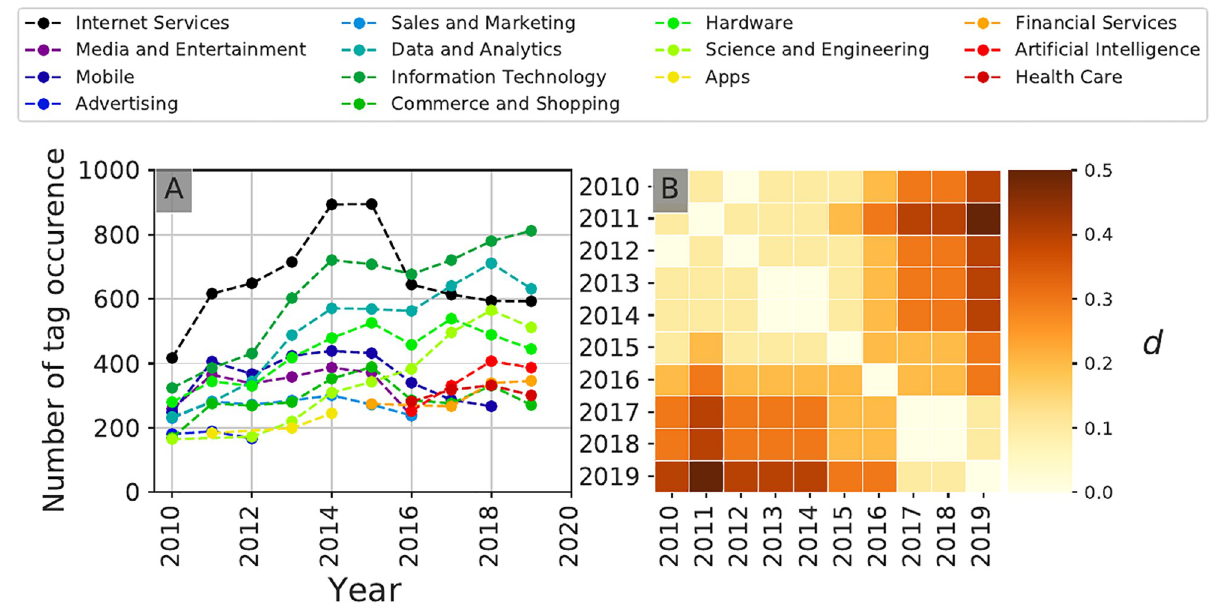
Fig 9. Temporal evolution of the investment patterns of community A0. Temporal community investment patterns of the target startups’ sectoral tags for each year aggregated at the community level. Community A0 is comprised of large, historical, rather late-stage focused venture capital firms. Panel A shows for each year the ten tags that received the most investments, panel B shows the community self-difference index described in Eq 4. We see a gradual but consequent shift in the target industries of community A0 throughout the period of study as evidenced in panel B , notably with the disappearance of relatively low-tech sectors such as the Mobile , Apps and Advertising sectors.